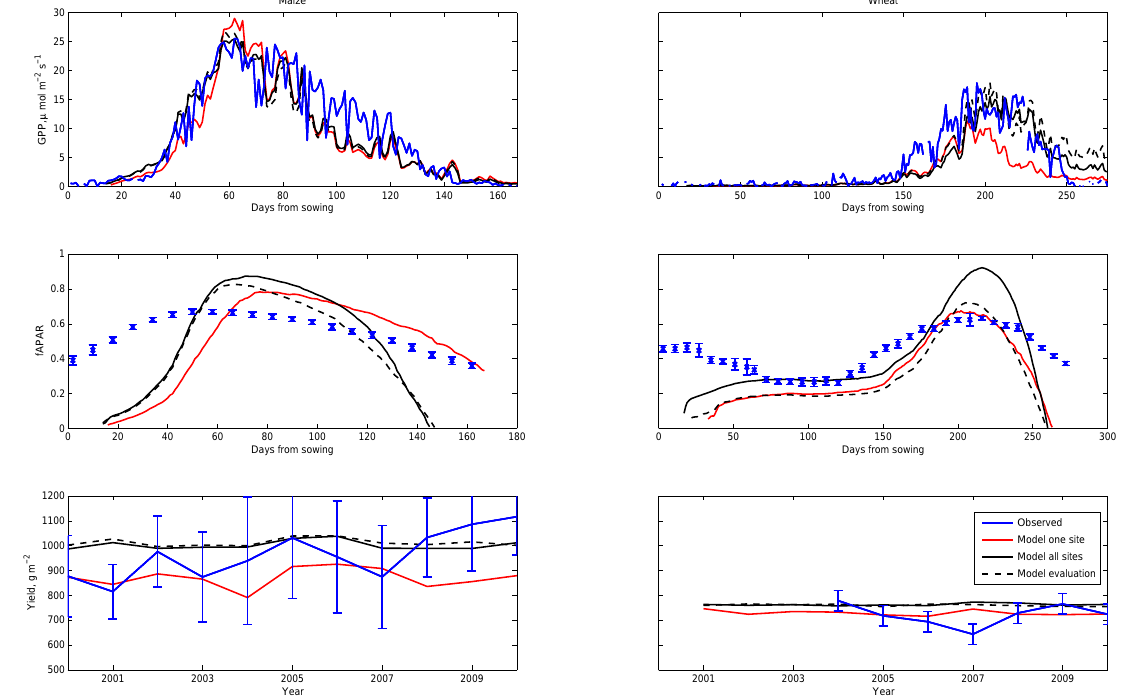
Figure 3. GPP, fAPAR and yield model predictions at one maize site (US-Ro3) and one wheat site (DE-Gri). The figure shows posterior mean predictions for one site, all sites and the evaluation model fit. Neither site has been included in the evaluation